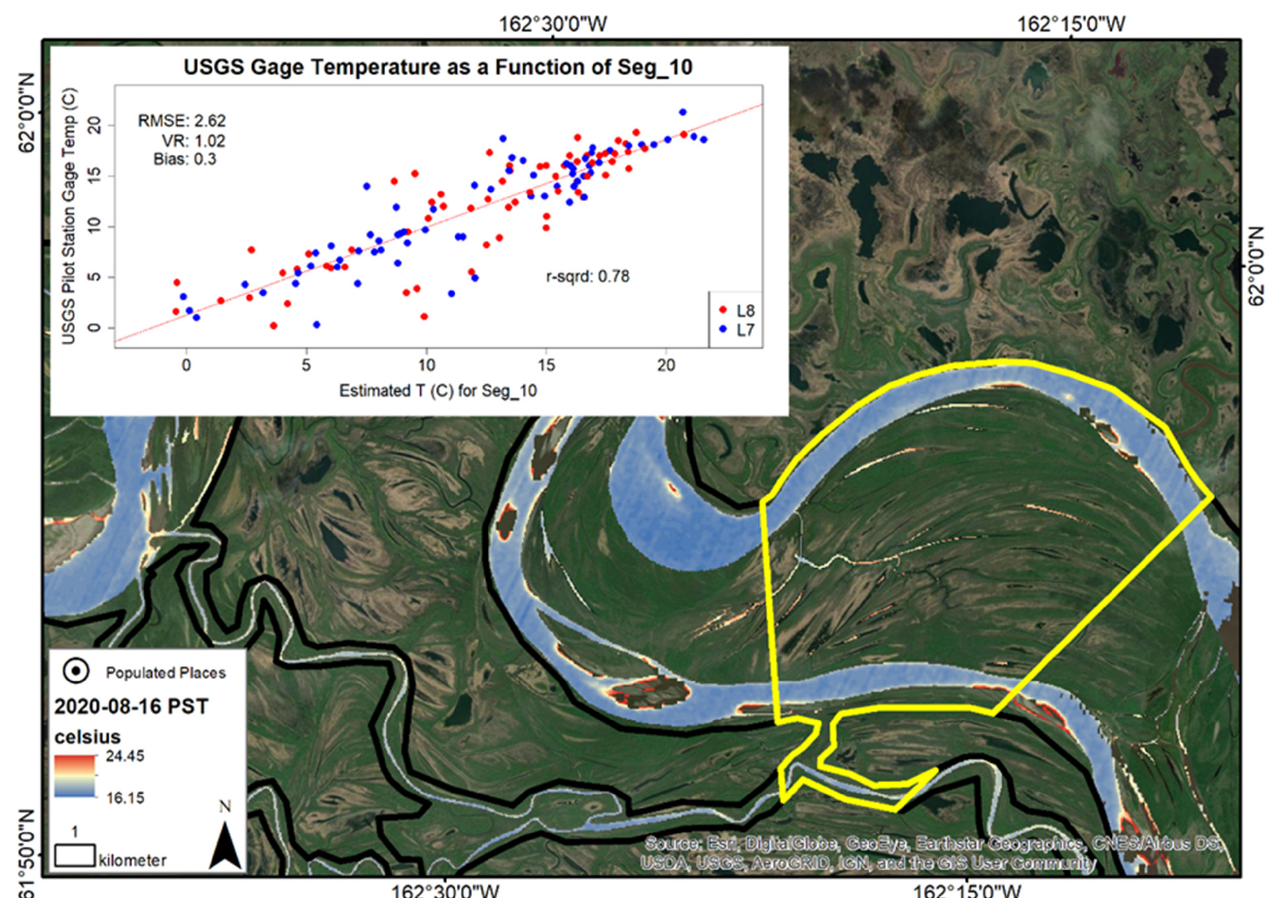
Figure A8. Within segment 10, the Yukon River is divided into three unique sections. Poltes Slough is the most northern one, while the main stem of the river is on the southern side of a large island, and a section of Owl Creek is furthest south. Wetlands surround all portions of this segment, given that the Yukon River leaves the last of the Ilivit Mountains in segment 9. The pST coverage for open water within this section is nearly 100% with no significant NoData gaps. At high stages, western portions of the large island can become inundated and present as warmer temperature water. These high water events occur during spring break-up. Depending on the proportion of the Yukon River that is also captured during these events, these inundated areas could significantly affect the average pST estimate for the segment. Correlation with measured water temperature is similar to all preceding river segments with an RMSE = 2.62 °C and r 2 = 0.78.